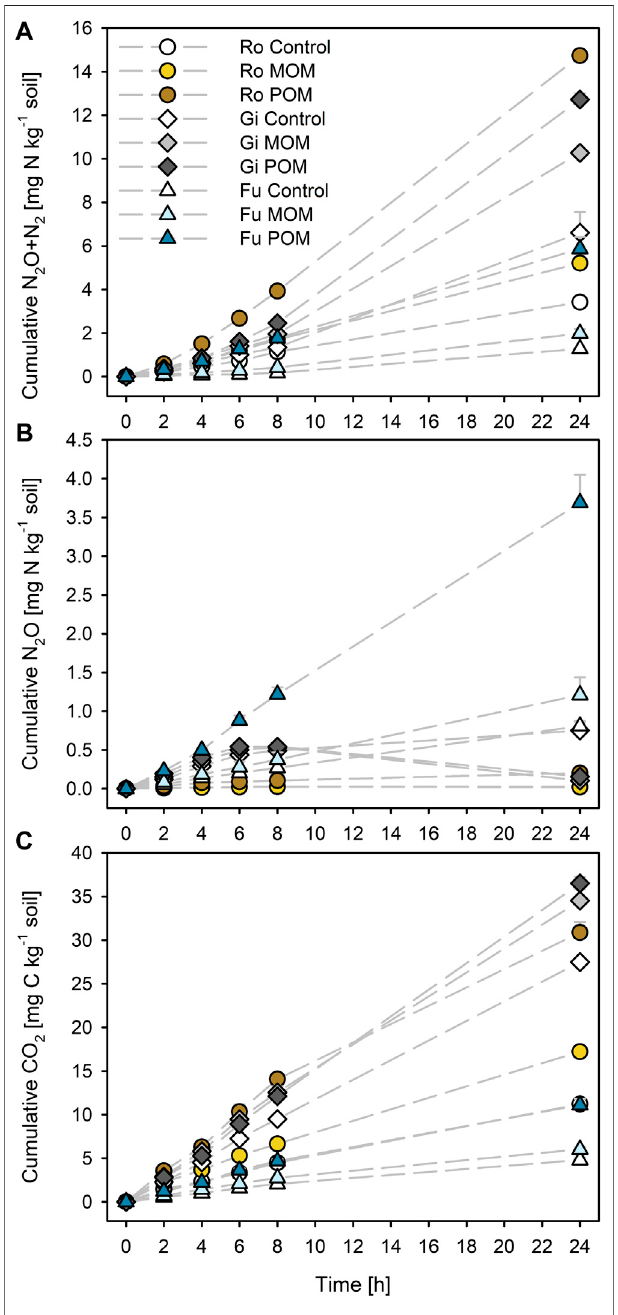
FIGURE 1 | Cumulative (A) N 2 O + N 2 , (B) N 2 O, and (C) CO 2 production during anoxic incubation at 20 ° C of the soils from Rotthalmünster – Ro, Giessen – Gi, and Fuhrberg – Fu without (control) and with addition of soil- derivedparticulate andmineral-associatedorganicmatter(POM, MOM). Error bars represent SD of means (n (cid:2) 3). All incubations received initial KNO 3 additions of 50 mg NO 3 − -N kg − 1 dry soil.